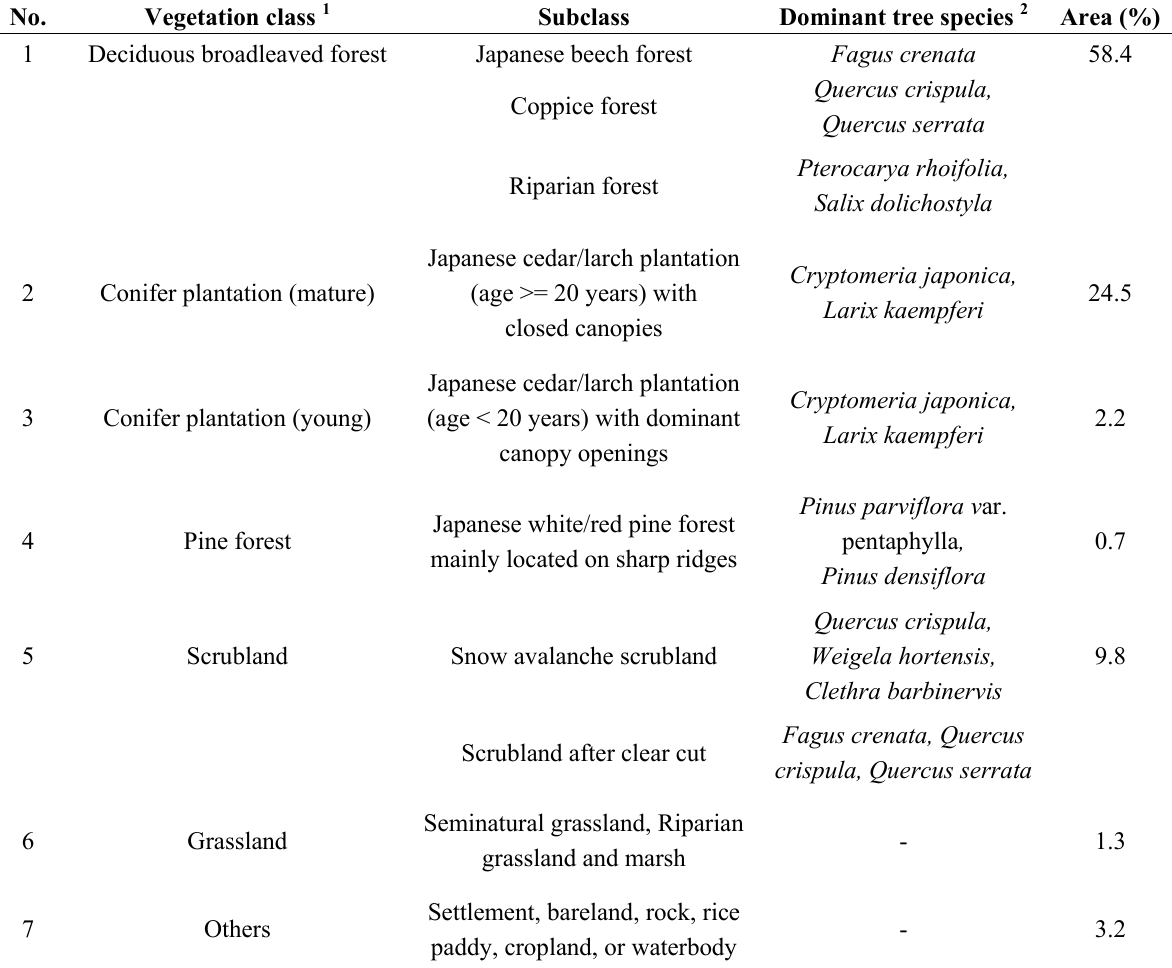
Table 2. Vegetation classes and dominant tree species in the study